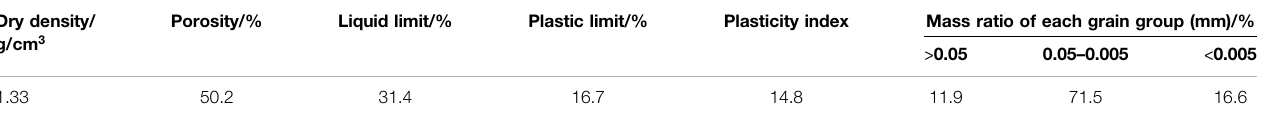
TABLE 1 | Physical properties of the loess.